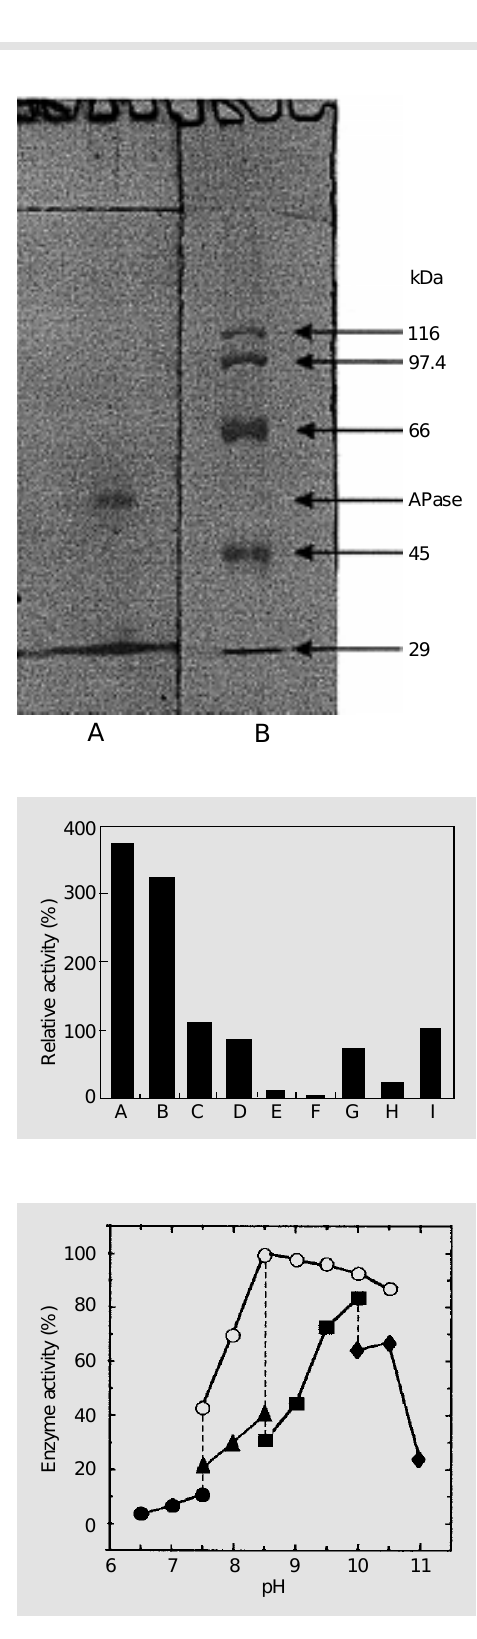
Figure 3 - SDS-PAGE of purified alkaline phosphatase synthe- sized by N. crassa mycelium grown for 72 h on high-Pi medi- um. About 10 µg of purified pro- tein was loaded onto lane A and stained with silver after electro- phoresis. About 1 µg of protein markers (lane B) was stained with Coomassie blue after elec-